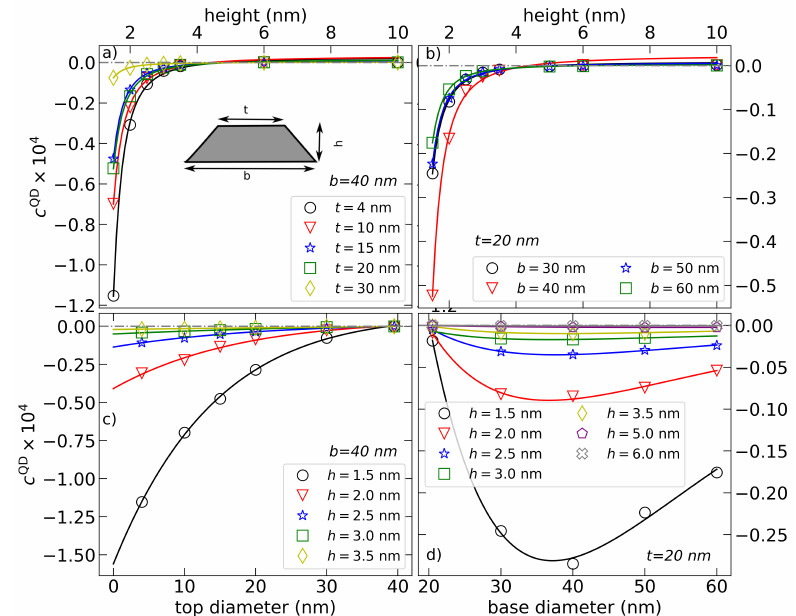
Figure 1. Comparison of c QD (multiplied by factor 10 4 ) extracted from k · p simulations (symbols) with the model Equation (4) (curves) for QD with fixed b = 40 nm and varying t and h [panels ( a ) and ( c )], and QD with fixed t = 20 nm and varying b and h [in ( b , d )], respectively.